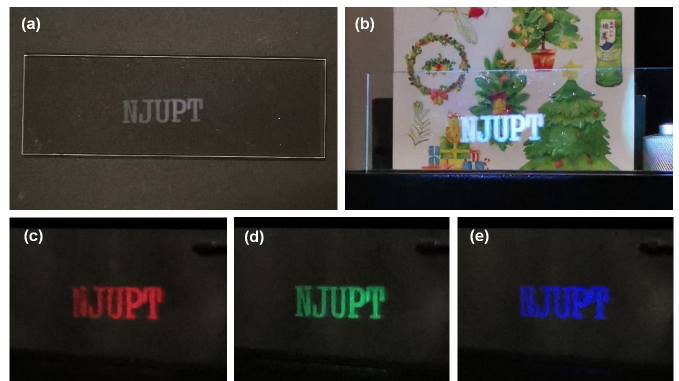
Figure 9. ( a ) Photograph of the laser-printed letters NJUPT on a glass slide. ( b – e ) Letters were light up by white, red, green, and blue light.